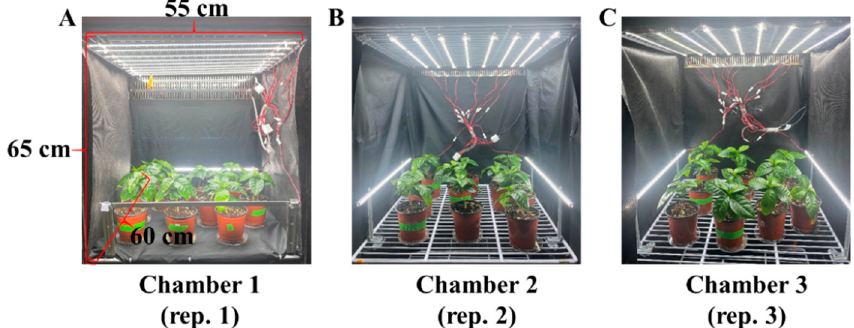
Figure 11. The experimental layout and growth condition of plant growth chambers for coffee plants. Figures ( A – C ) refer three plant growth chambers and three replications of plant growth chambers in this experiment.